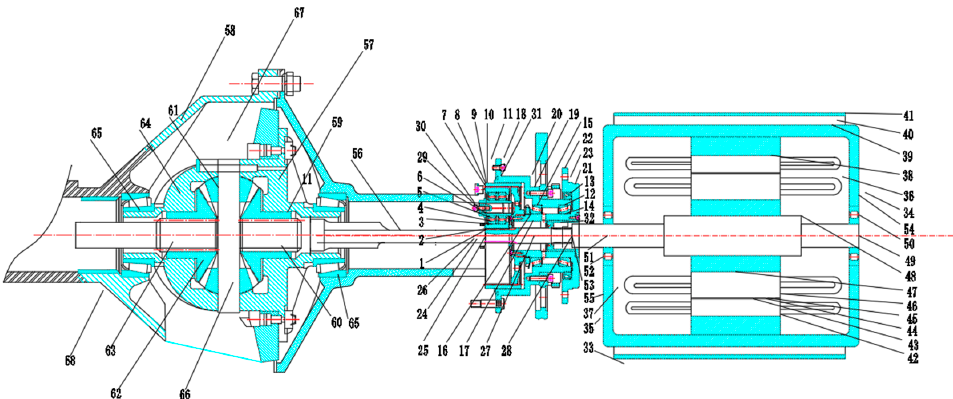
Figure 6. The structure of the planetary automobile drive axle.